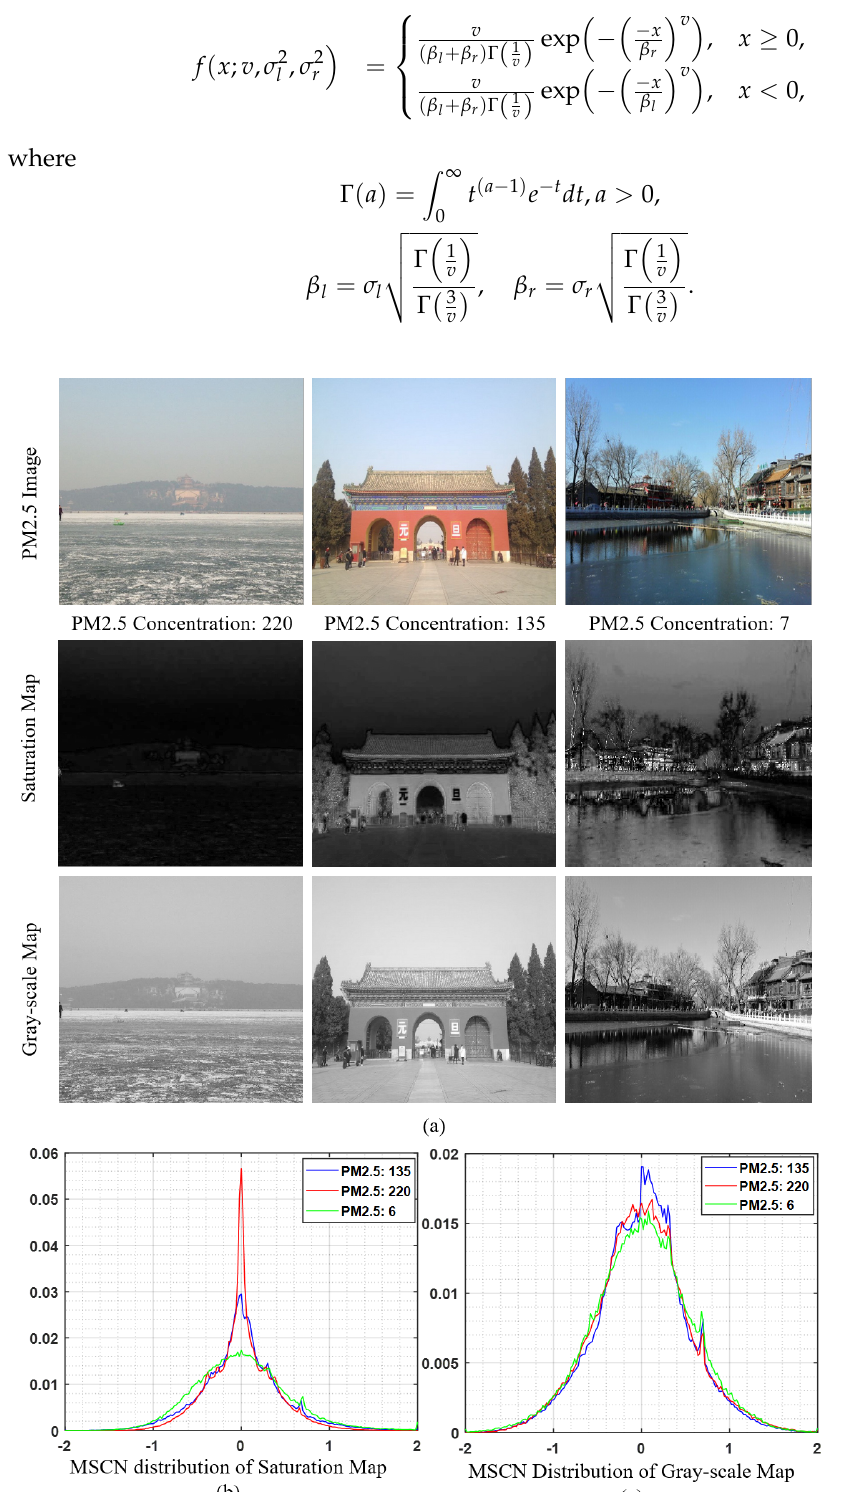
Figure 3. The MSCN distributions of the three PM 2.5 photos with different rank concentrations and their corresponding saturation and grayscale channels. ( a ) The PM 2.5 images and their corresponding saturation and grayscale channels. ( b , c ) MSCN distributions of the saturation and grayscale channels,